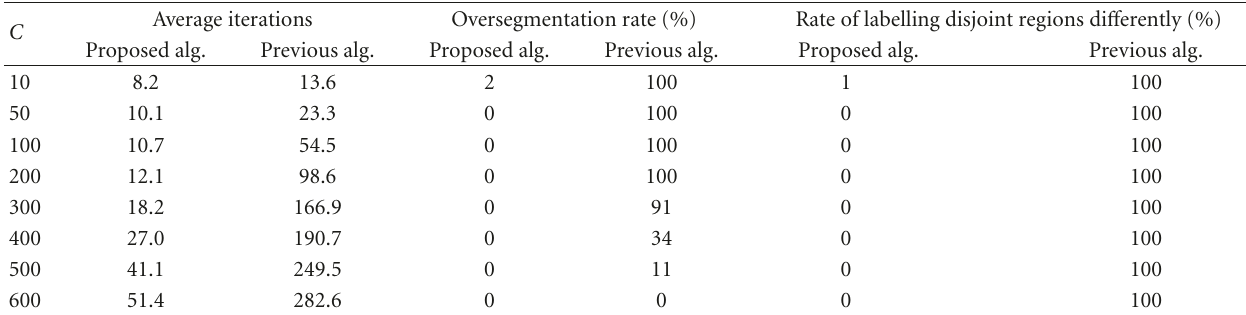
Table 2: Performance in terms of computational cost measured by average iterations, oversegmentation rate, and rate of di ff erently labelling disjoint regions of the same texture (%) with various values of C when the image in Figure 3 is divided into 256 blocks.